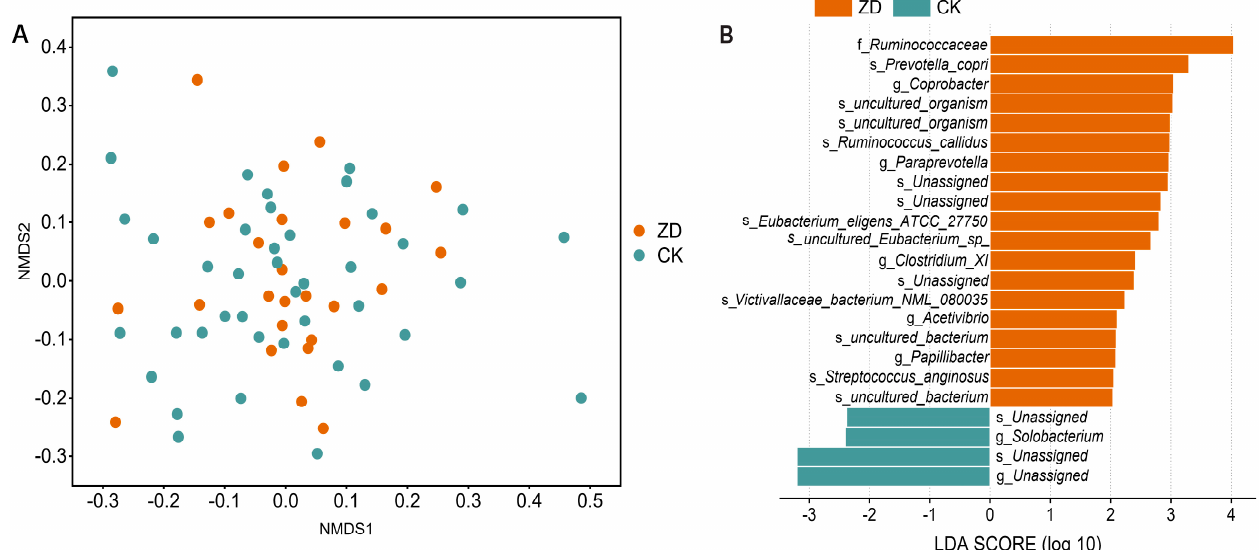
Figure 1. Microbial community diversity and differential taxa in ZD and CK groups. ( A ) NMDS showed β -diversity using Bray–Curtis distance. Each dot represented one sample, and two colors represented two groups, respectively. ( B ) LEfSe identifying the taxa that significantly explained differences in community composition between ZD and CK groups.